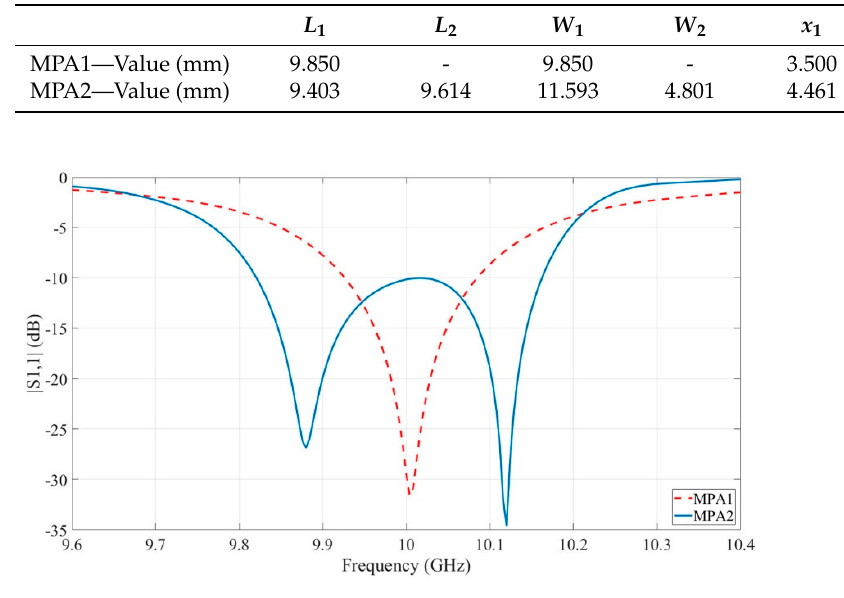
Figure 2. Simulated reflection coefficient for MPA1 and MPA2.